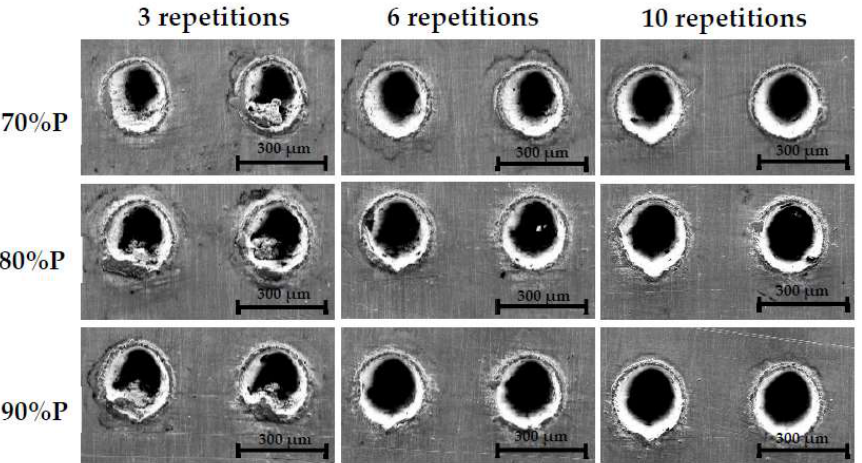
Figure 4. SEM images of the dimples obtained on the textured surface of the ASTM F-1537 cobalt alloy employing a repetition rate of 210 kHz.